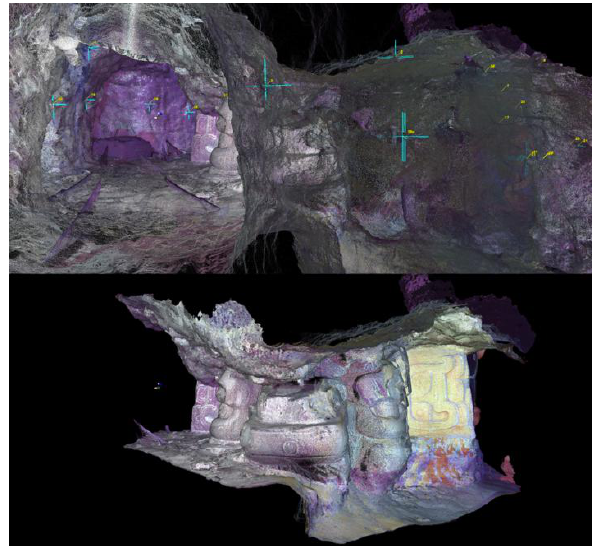
Figure 2. The tunnel dug from looters at the base of the acropolis